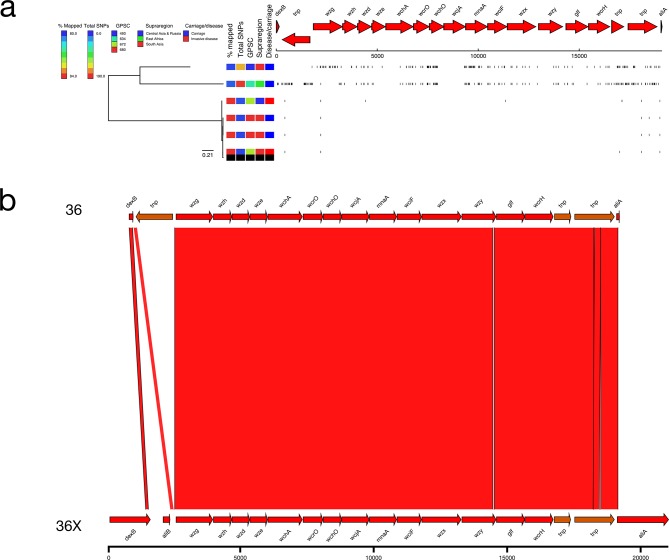
(a) Phylogeny and SNP map of serotype 36. (b) Comparison of the putative serotype 36X sequence and the serotype 36 reference sequence.